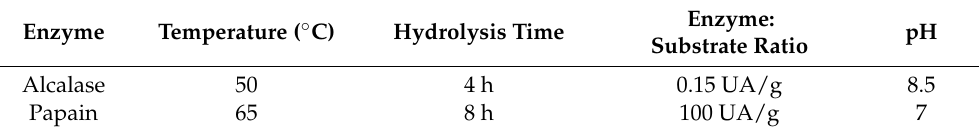
Enzyme: pH Substrate Ratio